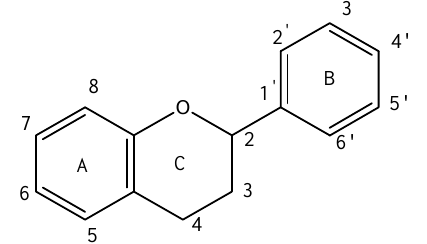
Generic structure of a flavonoid